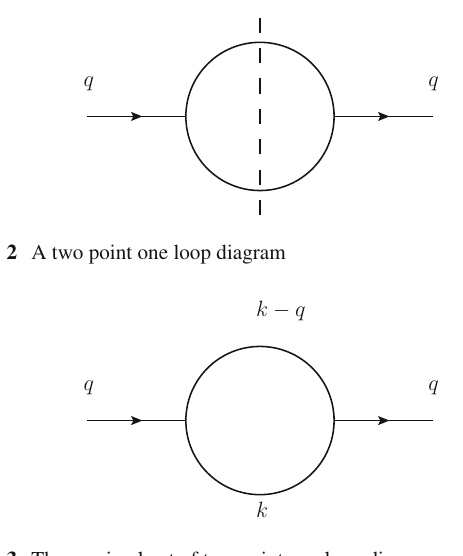
Fig. 3 The maximal cut of two point one loop diagram